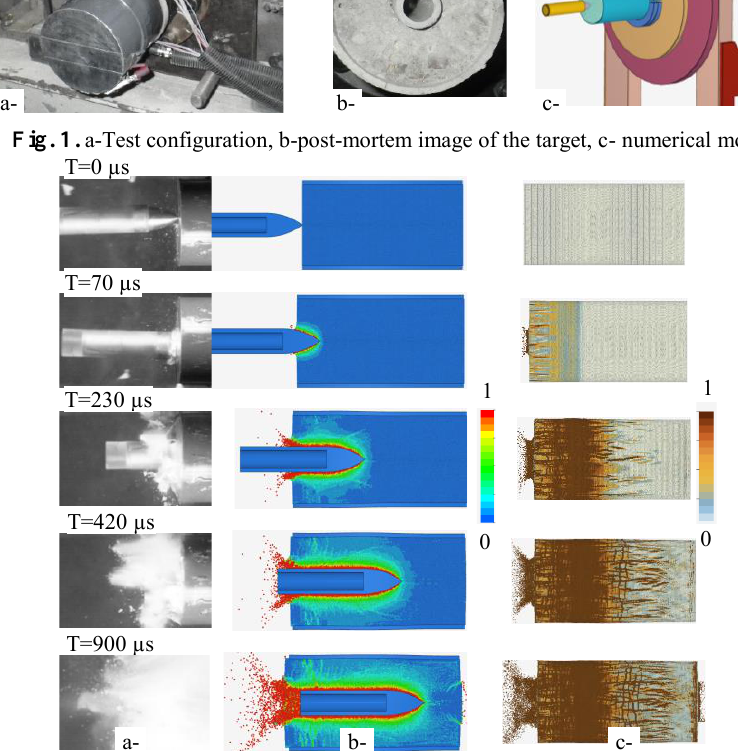
Fig. 2. Comparison of test with simulation: a-Images from high speed camera, b-Simulated concrete internal strain, c-Simulated concrete external